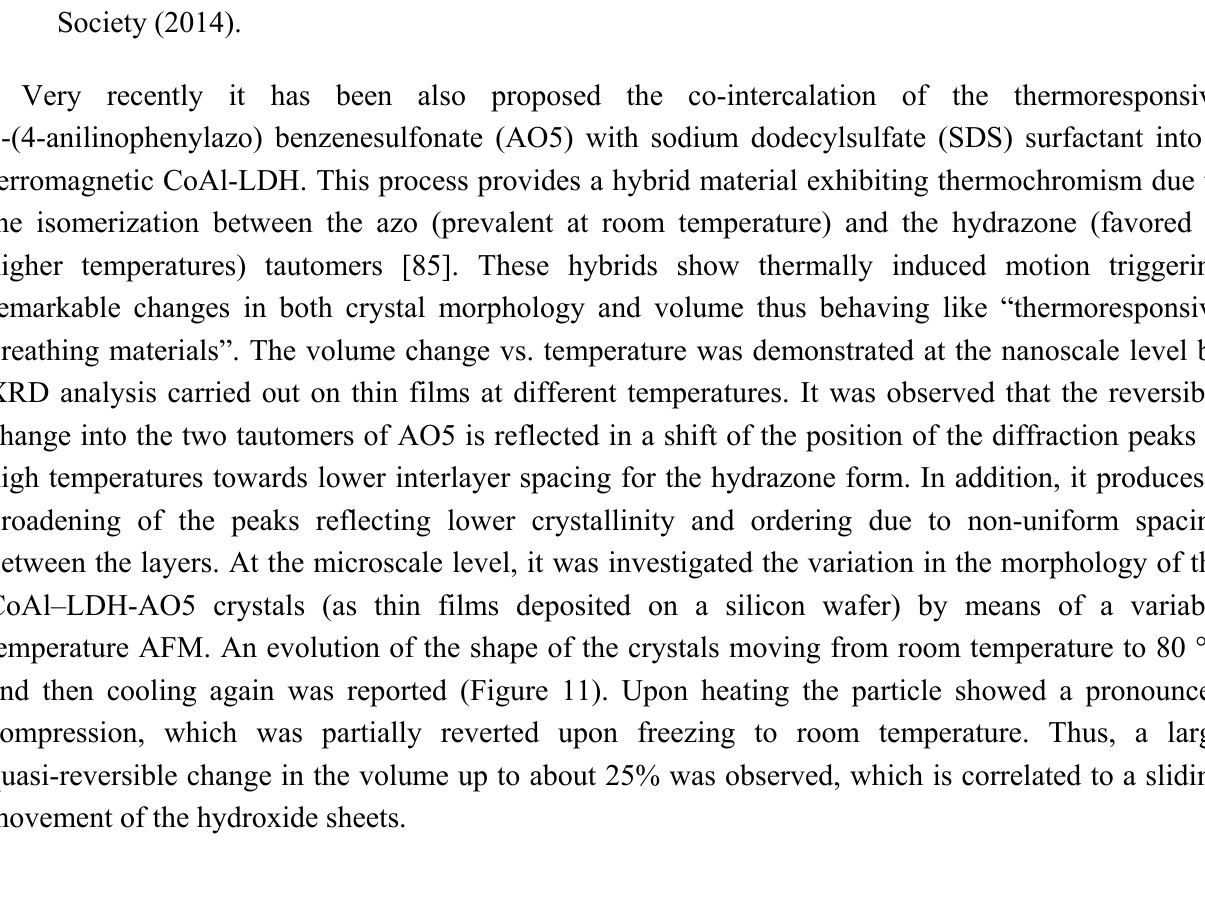
Figure 10. ( A ) Fluorescence spectra of the niflumic acid (NFC)-heptanesulfonate (HPS)/LDH sample containing 5% NFC before and after grinding; ( B ) In situ time-dependent monitoring of the fluorescence of the NFC-HPS/LDH sample containing 5% NFC responding to THF. Reprinted with permission from Zhao et al. [84]. Copyright American Chemical Society